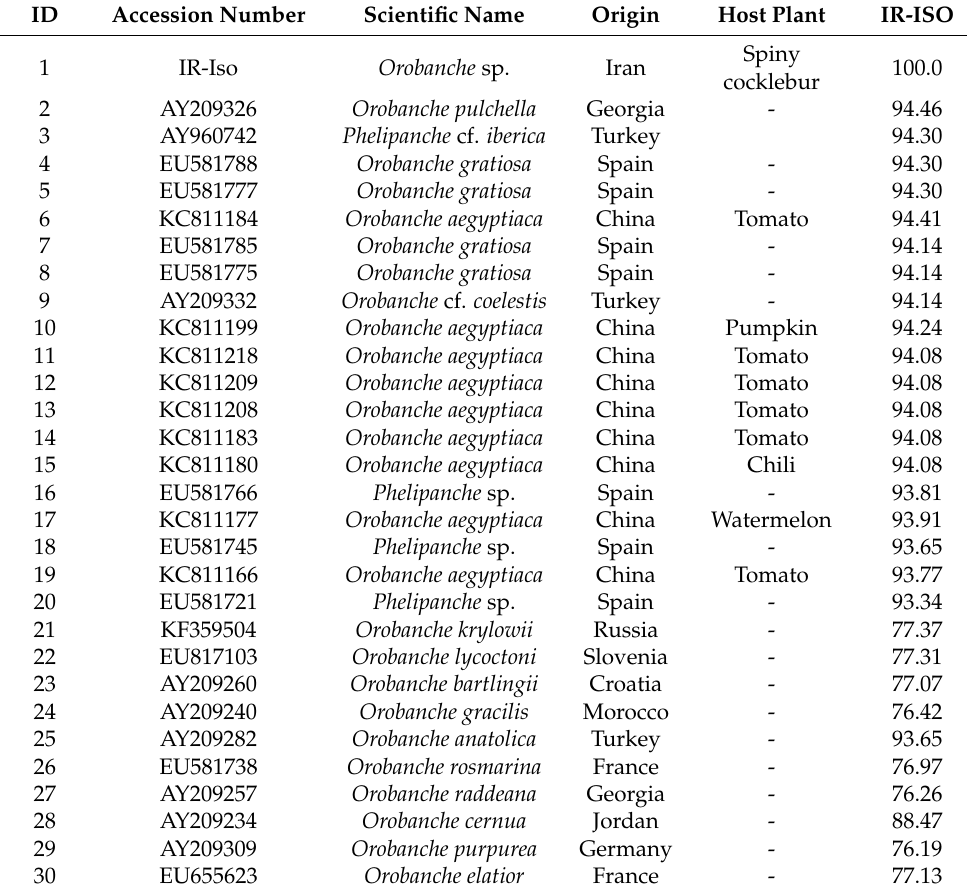
Table 1. Sequences showing similarity to IR-Iso ecotype after haplotype